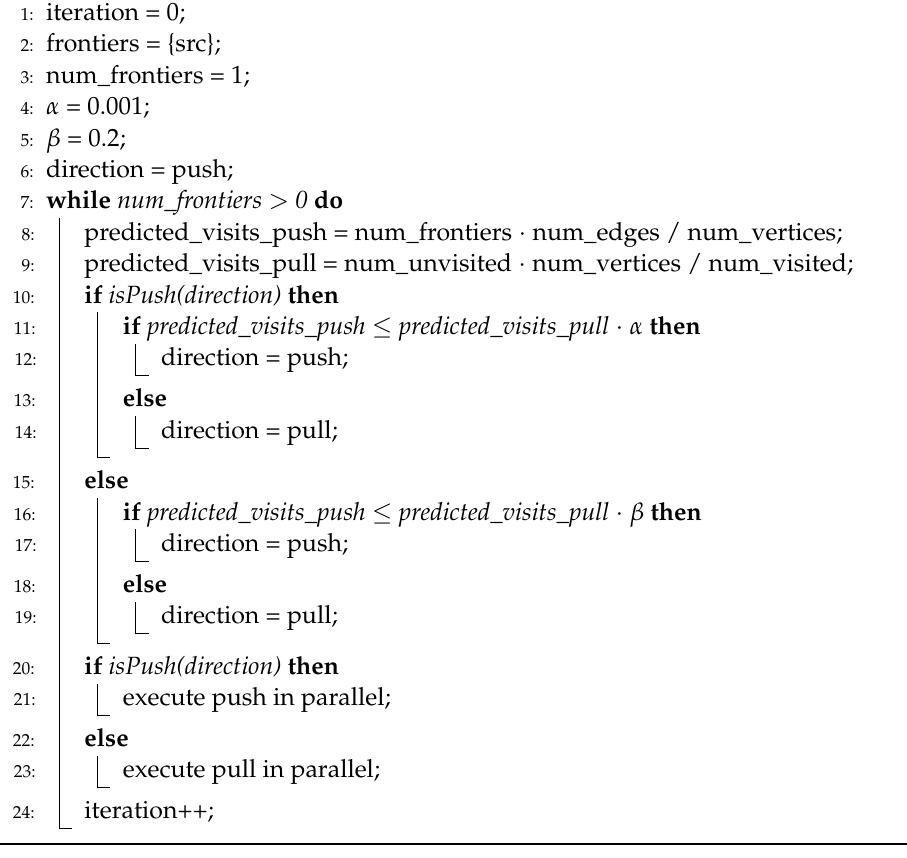
Algorithm 5 Direction-optimizing BFS in Gunrock.